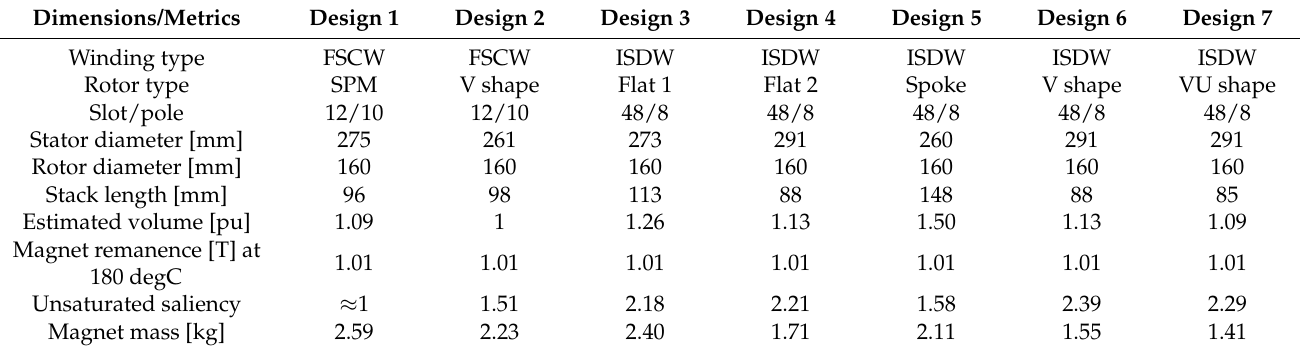
Figure 2. Cross-sectional views of seven baseline PM machines: ( a ) 12-slot/10-pole FSCW-IPM; ( b ) 12-slot/10-pole FSCW- SPM; ( c ) 48-slot/8-pole DW-IPM (spoke type); ( d ) 48-slot/8-pole DW-IPM (Flat 1); ( e ) 48-slot/8-pole DW-IPM (Flat 2); ( f ) 48-slot/8-pole DW-IPM (V shape); ( g ) 48-slot/8-pole DW-IPM (VU shape). Table 1. Summary of key information of the seven baseline PM machines. Table 1. Summary of key information of the seven baseline PM machines.